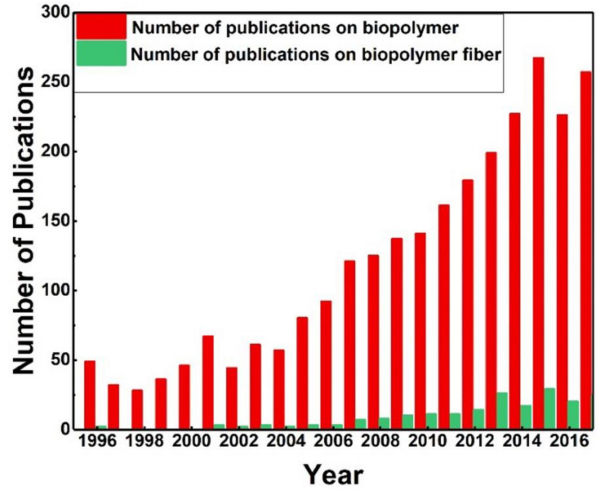
Figure 1. Comparison between annual publication of scientific journals from 1996 to 2017 between biopolymers and biopolymer fibers. [Obtained from Web of Science search system (24 March 2018) where the keywords were chosen as ‘biopolymer’ and ‘biopolymer